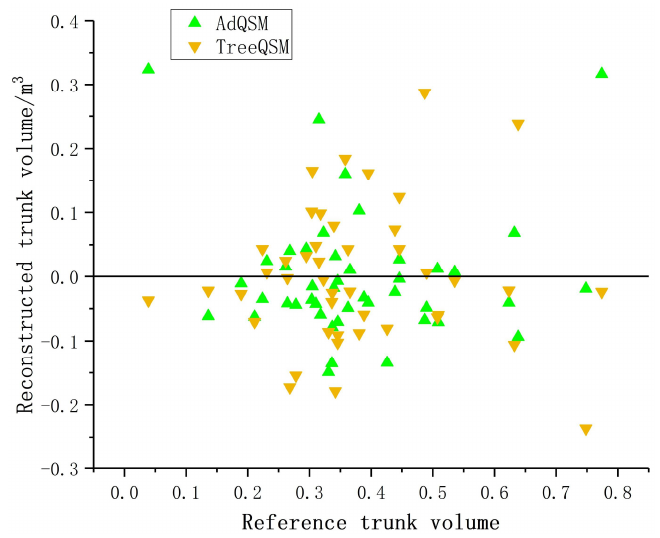
Figure 16. Trunk volume residual distribution of AdQSM and TreeQSM.